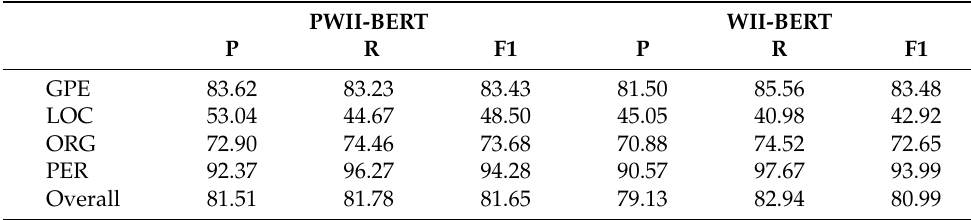
Table 7. Results of P, R, and F1 score on the Ontonotes dataset.